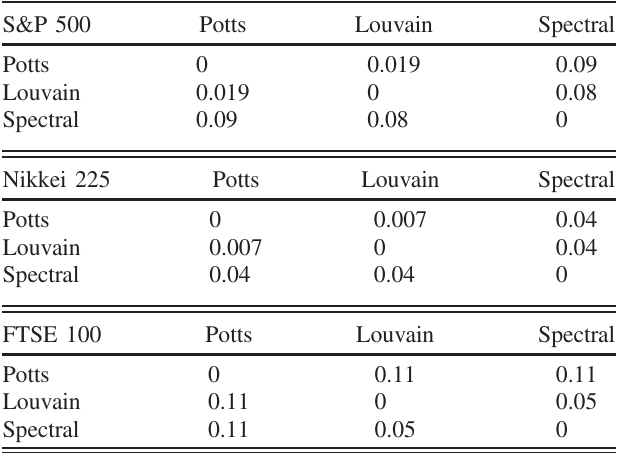
TABLE II. Comparison of the relative variation of information between the optimal partitions found by all algorithms, for the S&P 500, the Nikkei 225, and the FTSE 100. The data are log-returns of daily closing prices from 2001Q4 to